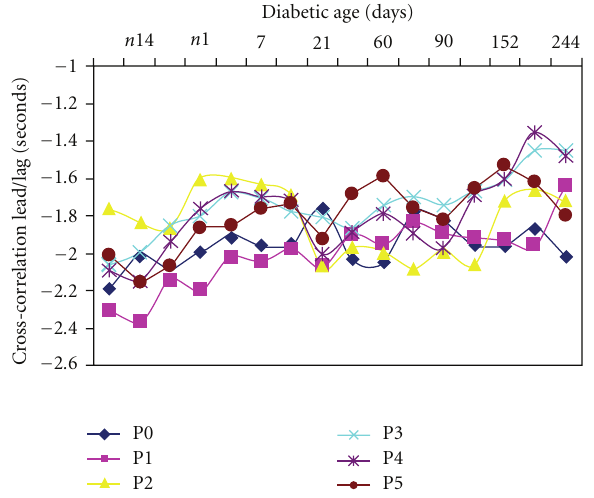
Figure 6: Changesin circadian rhythms ofcross correlation lead/lag time of HR and BP in BBDP rats over the nine months diabetic period. Values are mean ± SEM. ( n = 8). Note the gradual reduction in the lead/lag times with duration of